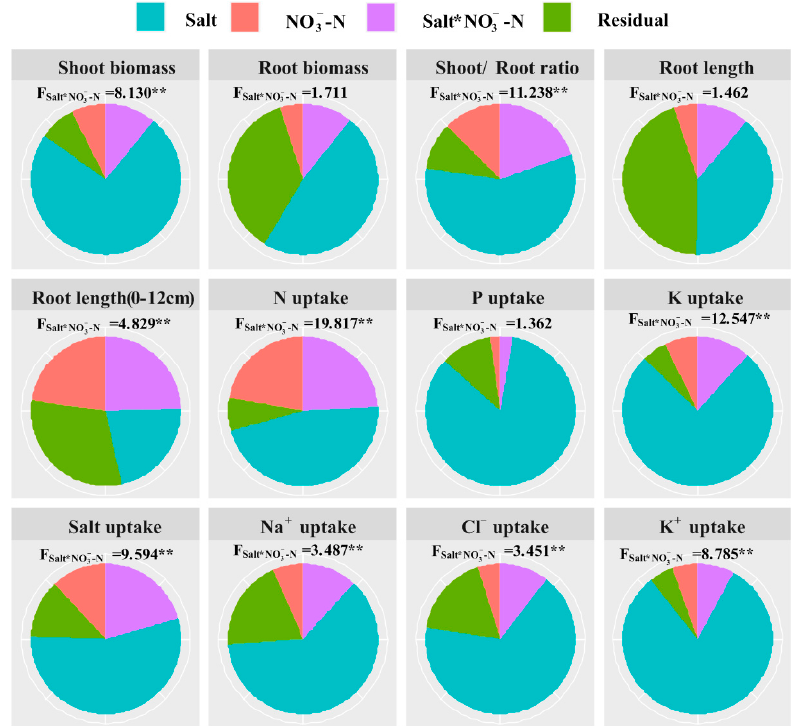
Figure 5. Results (F ‐ value) of two ‐ way ANOVA on the interactive effects of salt and N application on shoot and root biomass, root length and surface area, and ion and nutrient absorption of Suaeda salsa . The sector areas represent the ratios of the values in the sum of squares (SS: Salt, NO 3 (cid:2879) ‐ N, Salt * NO 3 (cid:2879) ‐ N and Residual) to total sum of square (SST). ** represented the significant level of 0.01 .